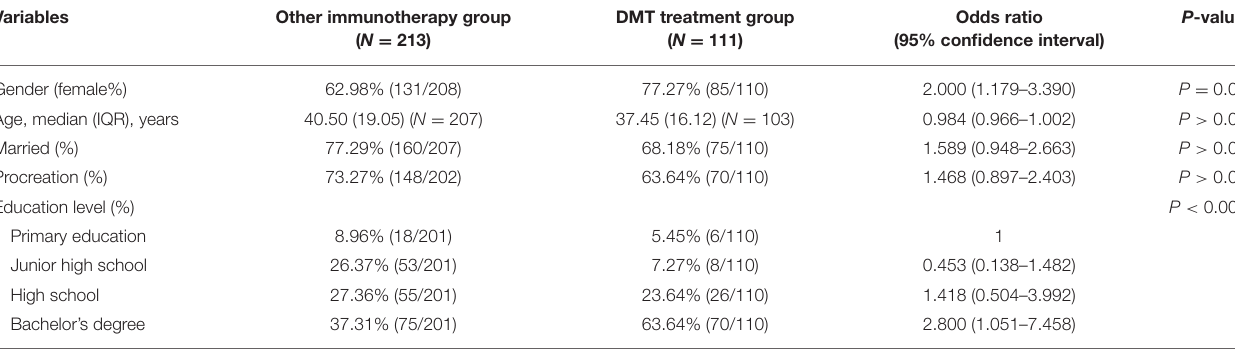
TABLE 4 | Patient characteristics of the DMT treatment group and other immunotherapy group.